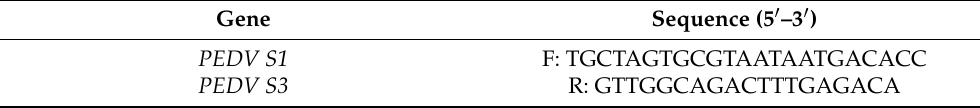
Table 2. Primer sequences for the amplification of the full-length PEDV S gene.